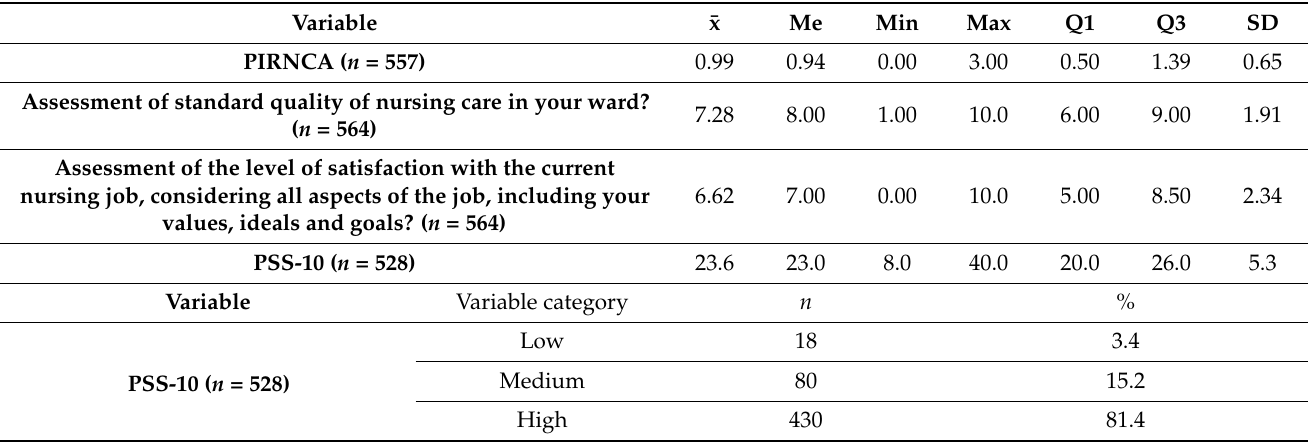
Table 2. PIRNCA questionnaire results and level of perceived stress among nurses participating in the study.